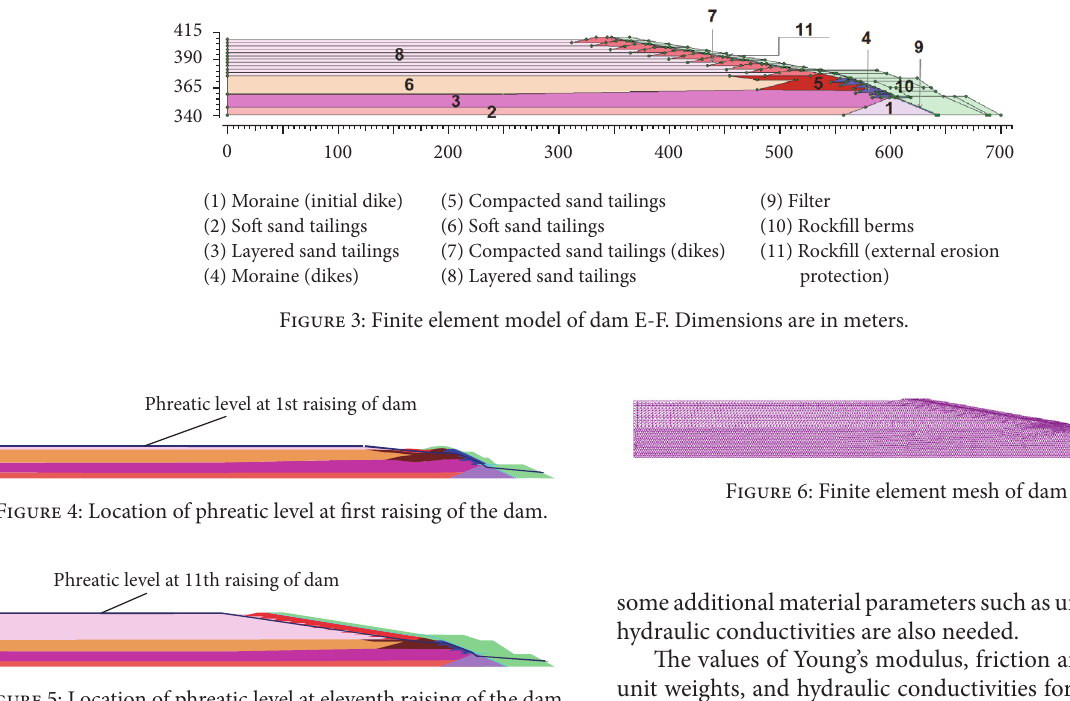
Figure 5: Location of phreatic level at eleventh raising of the dam.